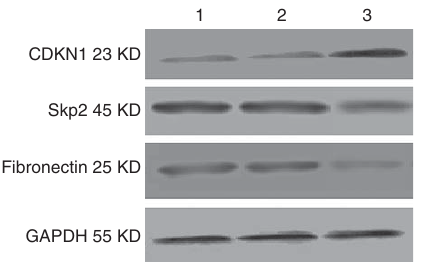
Fig. 6. Representative Western blot analysis of CDKN1, Skp2 and Fibronectin using GAPDH as internal control among SGC-7901, SGC-7901/EV and SGC-7901/let-7a cell lines. Compared with SGC-7901/EV and SGC-7901, SGC-7901/let-7a had obvious up- regulation of CDKN1, and a marked down-regulations of Skp2 and Fibronectin 1: SGC-7901; 2: SGC-7901/EV; 3: